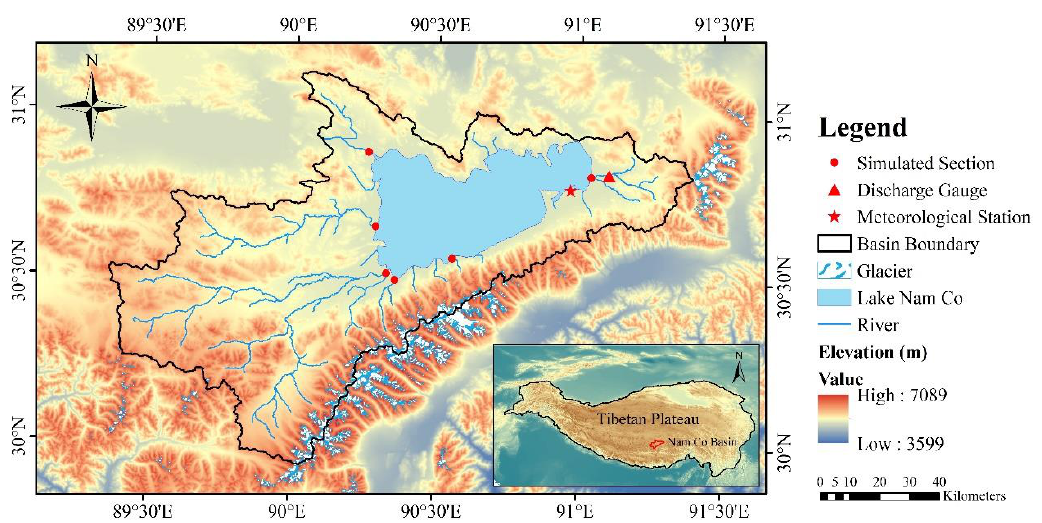
Figure 1. Topographic map of Nam Co Basin showing the river networks, meteorological station, discharge gauge, glacier distribution, and simulated lake inflow points.